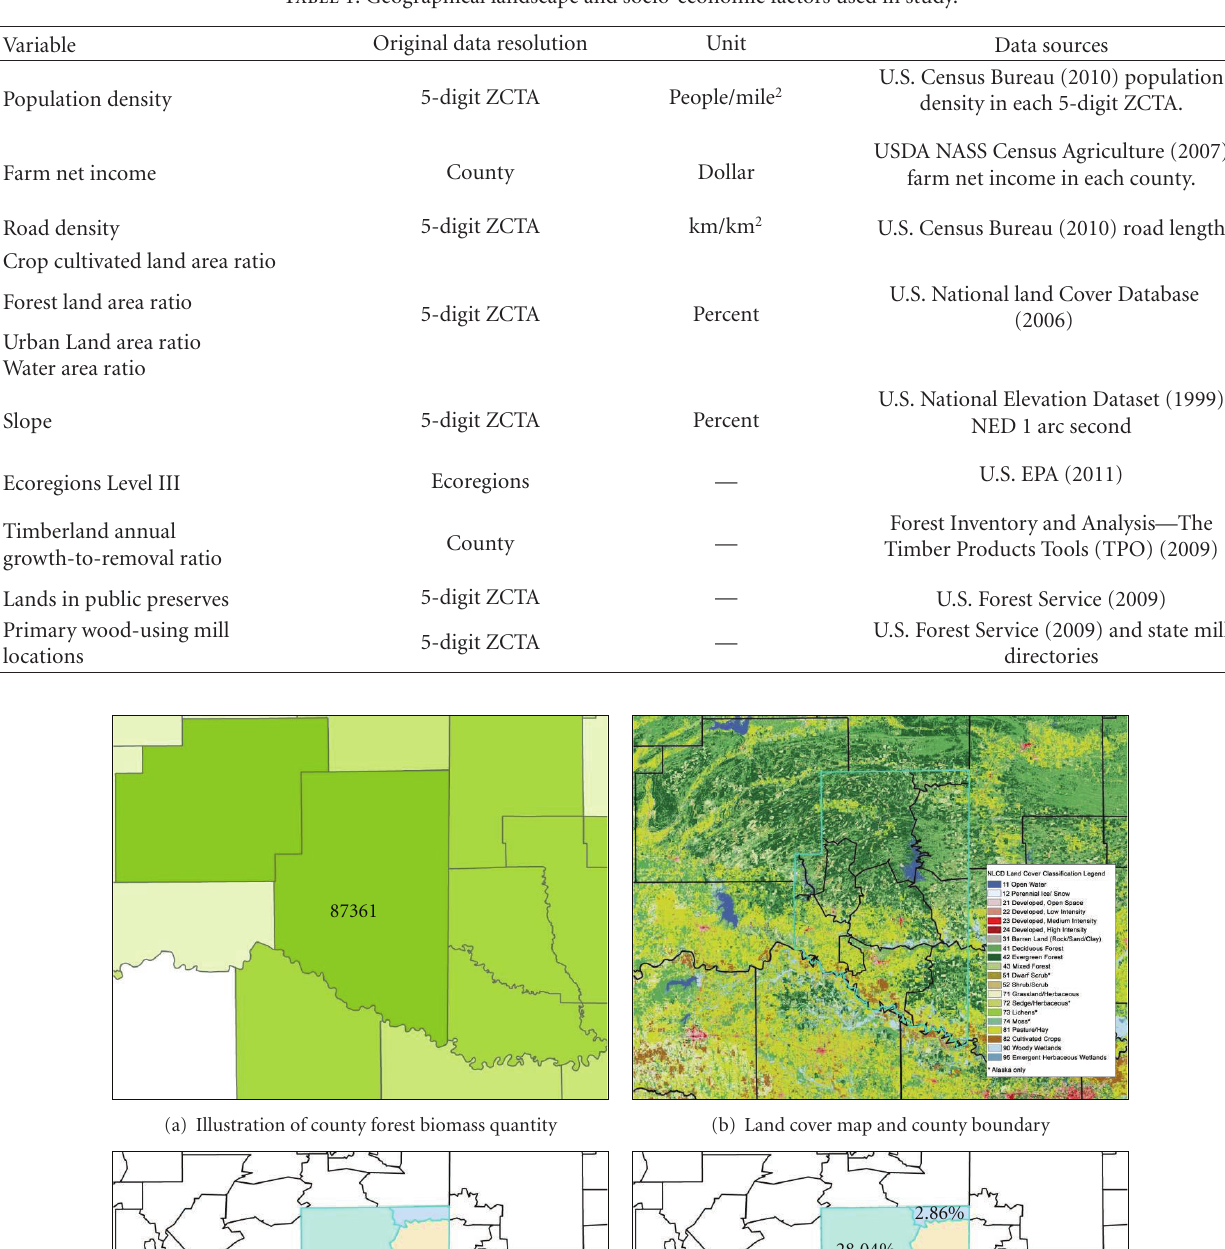
Table 1: Geographical landscape and socio-economic factors used in study.